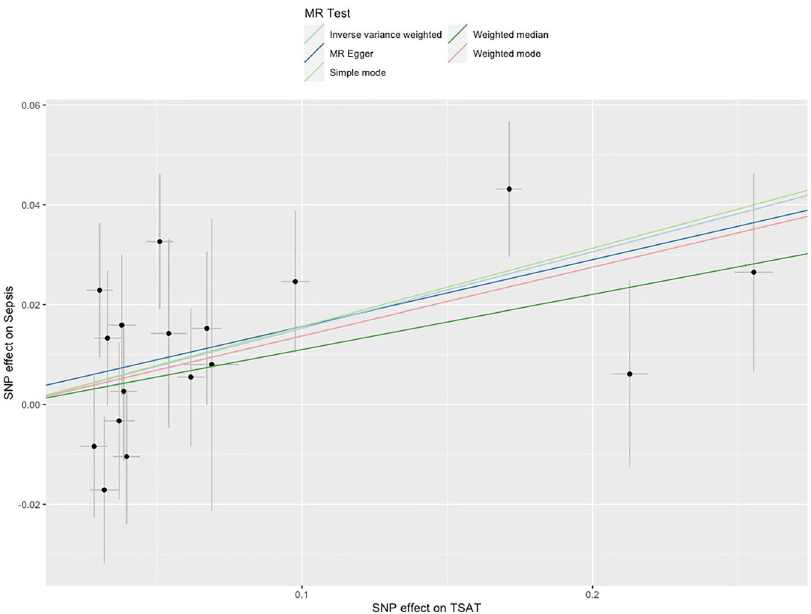
Figure 4. Scatter plot for increasing TSAT and risk of sepsis.